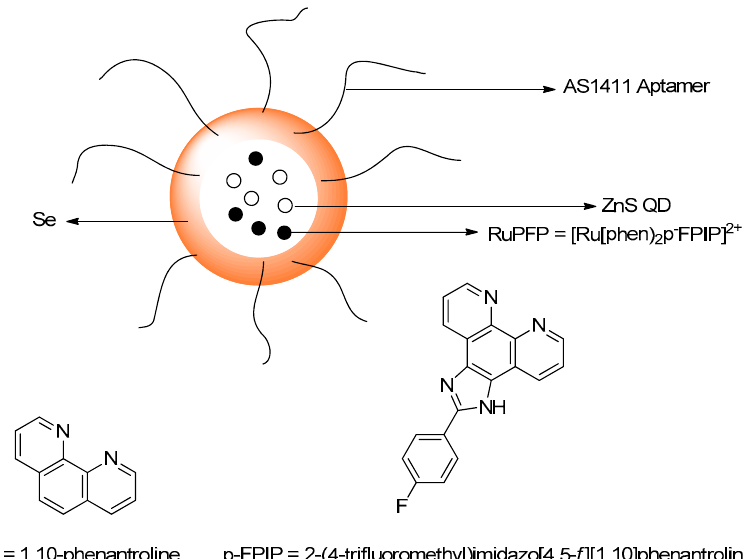
Figure 64. Structure of QDs/Se@Ru(A) by He et al. that is used to antagonize glioblastoma.